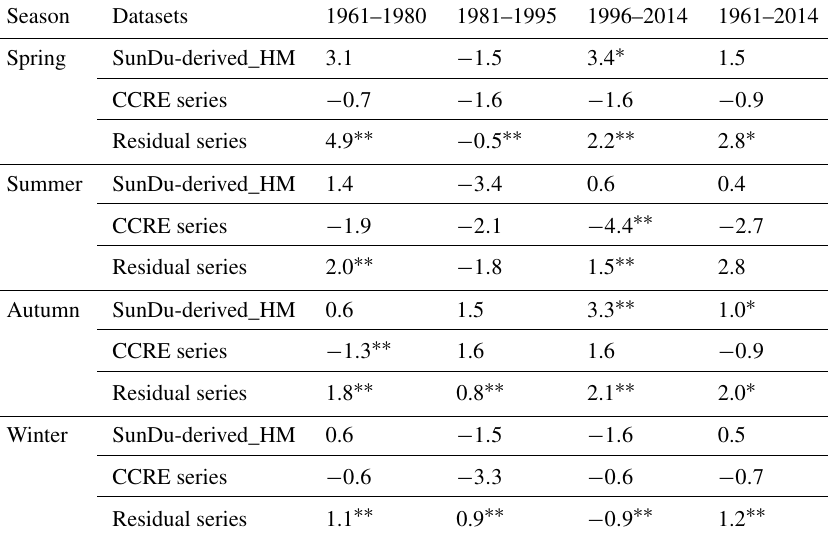
Table 2. Trends of surface incident solar radiation ( R s ) in Japan during specific time periods for different types of datasets for all seasons. Unit: Wm − 2 per